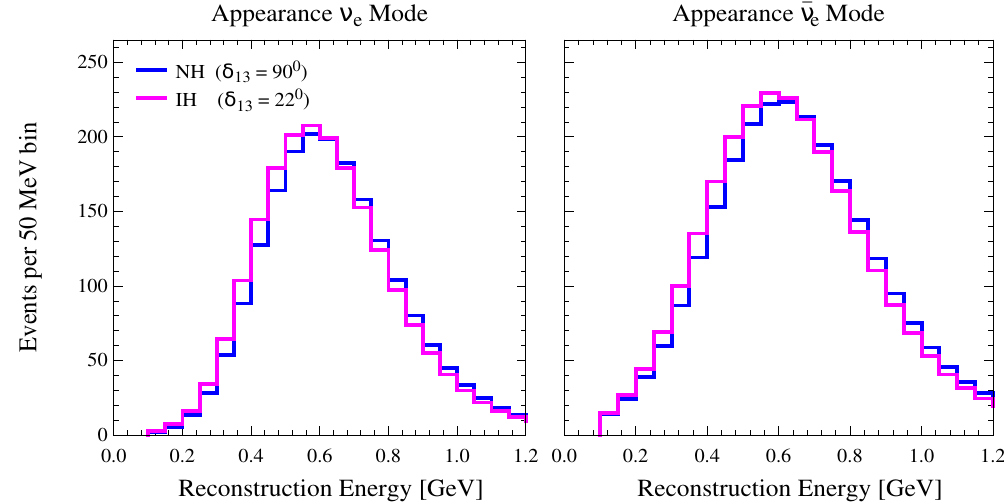
Figure 2 . Energy spectra for neutrinos (left panel) and antineutrinos (right panel) for NH (blue lines) and IH (magenta lines). The values of the CP-phase for NH and IH have been chosen so that the total number of neutrino and antineutrino events are basically identical for the two hierarchies. In this case, the noticeable residual sensitivity to MH (4 (cid:27) according to right panel of (cid:12)gure 1 for (cid:14) 13 = 90 0 ) is entirely provided by the energy shape